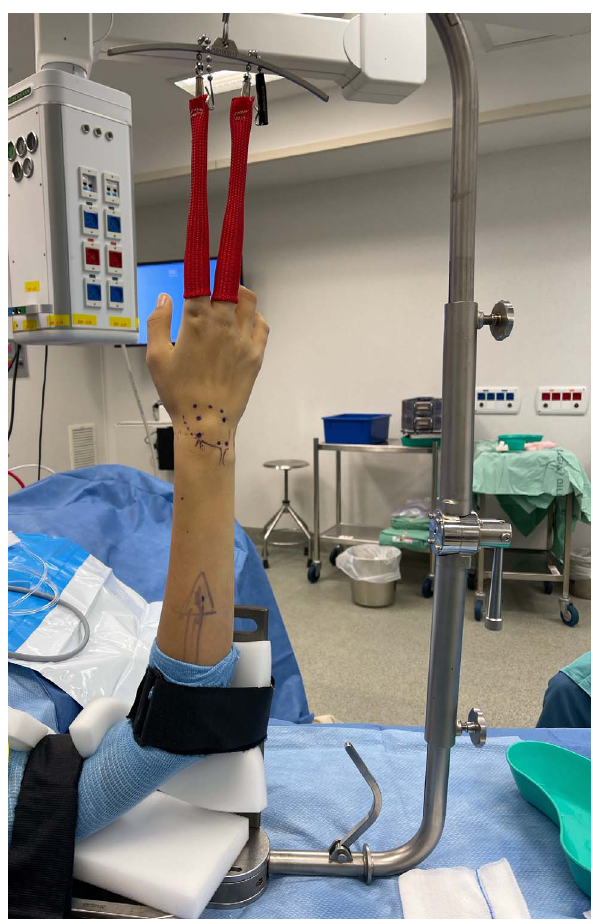
Figure 1. A speci fi c wrist arthroscopy tower is usually used, providing vertical distraction from the hand table upwards.